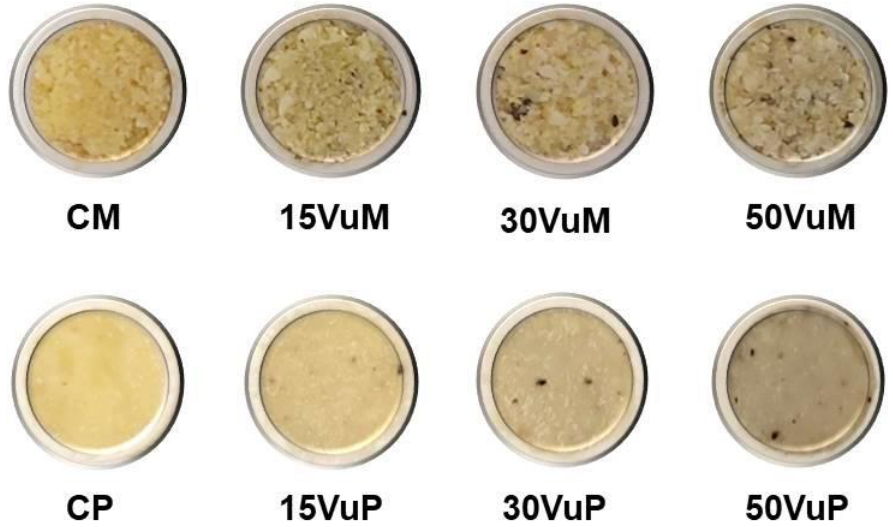
Figure 7. The appearance of the mixtures (M) and powder (P) with different concentrations (15, 30, and 50%) of Vigna unguilata (Vu) and the respective controls (CM and CP), hydrated for 18 h according to the SWE methodology.